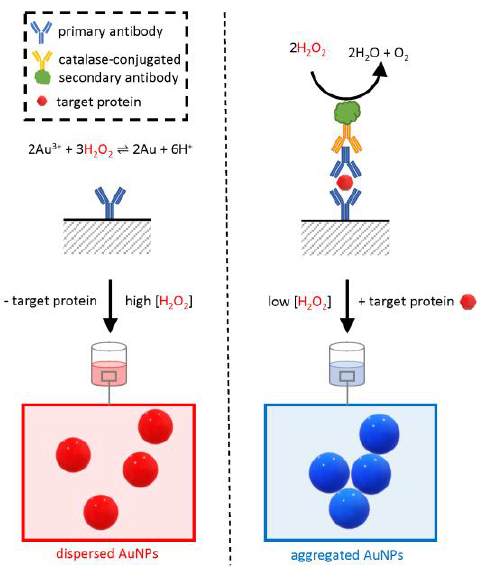
Figure 7. Schematic of the working principle of plasmonic ELISA. The assay is similar to a conventional double-sandwich ELISA; however, the readout is based on the in situ synthesis of AuNPs by gold (Au) reduction due to hydrogen peroxide (H 2 O 2 ). The synthesized AuNPs confer a bright-red color to the test solution. Instead, when the target protein is present, the enzyme catalase is retained in the test well and catalyzes the removal of H 2 O 2 , causing the formation of an aggregated blue colloid.